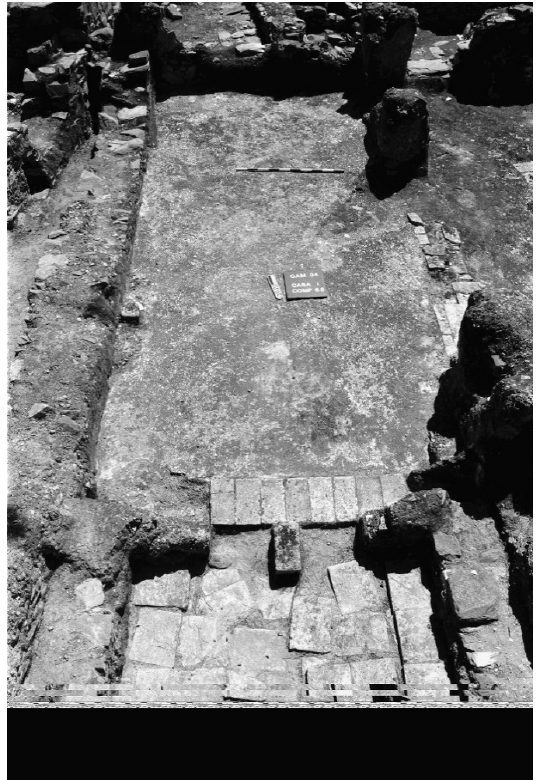
Figure 8. Mértola—house n. 1 (main room). Photo took by author.